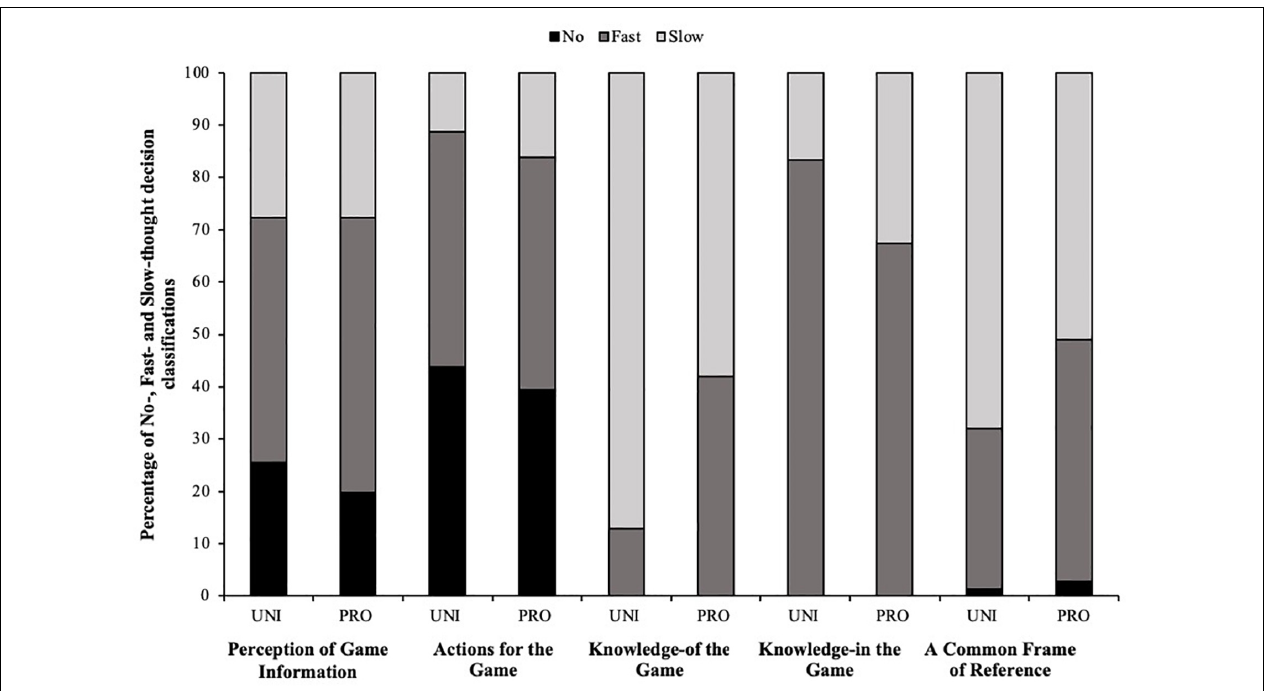
FIGURE 2 | Percentage of No-, Fast- and Slow-thought decision classifications for UNI and PRO groups for each deductive